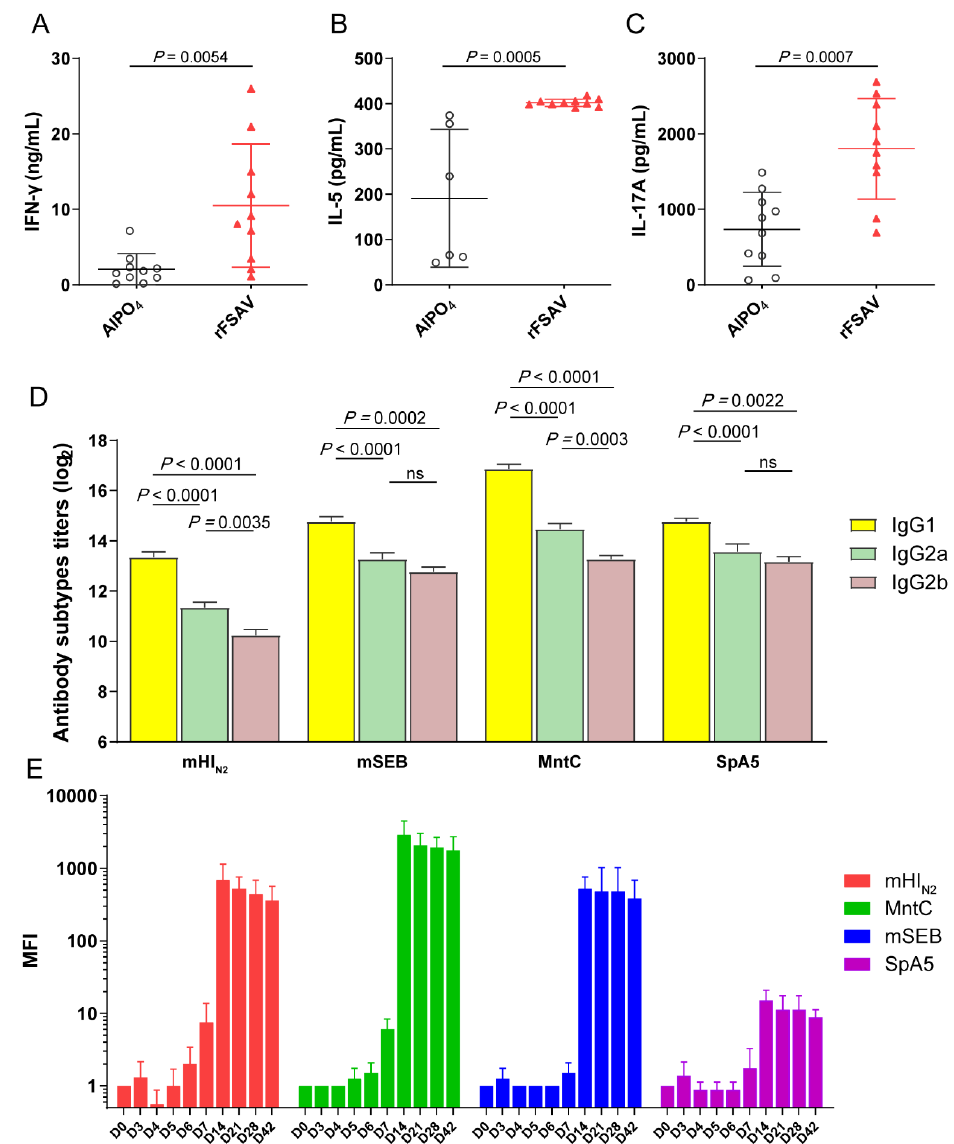
Figure 4. Analysis of cytokine and antibody responses. ( A – C ) Comparison of cytokine production by antigens stimulated splenocytes from immunized and control mice. 10 days after the final immunization, spleens ( n = 5) were processed and stimulated recombinant proteins, and the levels of IFN- γ , IL-5 and IL-17A in each culture supernatant were measured after 72 h. The di ff erences were compared using Student’s t -test. ( D ) Comparison of serum IgG1, IgG2a and IgG2b subtypes among antigens in the immunized mice ( n = 5). Serum was obtained at 10 days after the final immunization, and the levels of IgG1, IgG2a and IgG2b subtypes were expressed as the mean of log 2 titers. ( E ) The specific IgG of mHI N2 , MntC, mSEB and SpA5 in mice immunized with rFSAV was detected at each time point from days 0 to 42, and the levels of each antigen specific IgG were expressed as Mean Fold Increase (MFI). ( D , E ) Data were shown as the mean ± SEM. The p -values were calculated using one-way ANOVA (ns = no